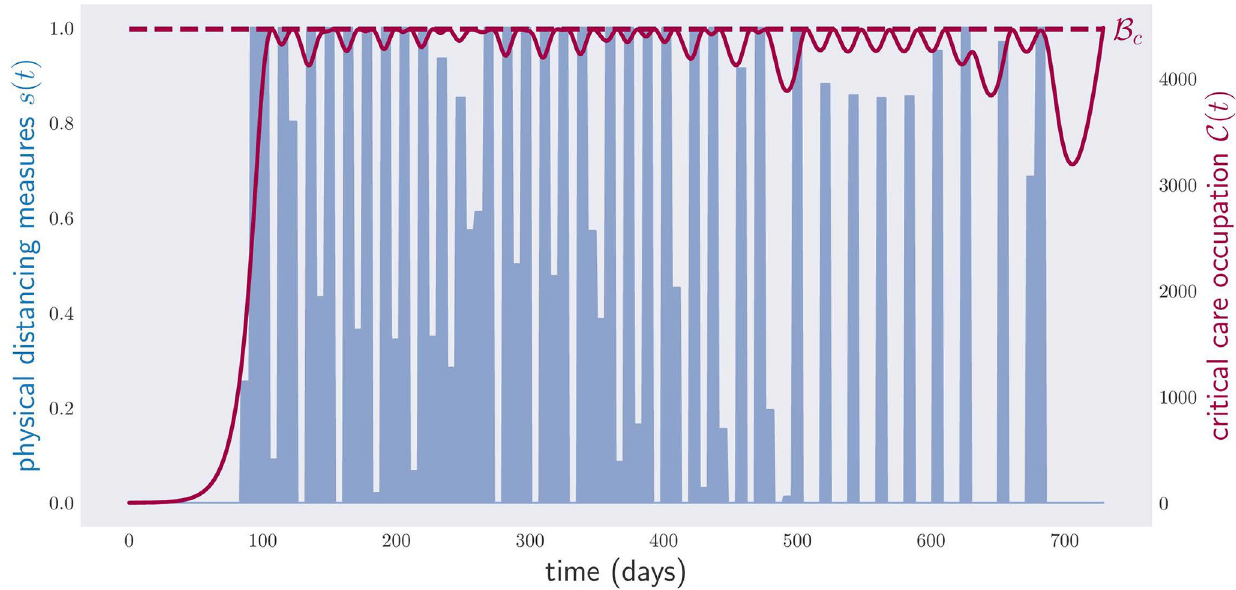
Fig 4. Occupation of critical care beds (red) and physical-distancing measures (blue) for a period of two years. The optimization has been performed over continuous weekly policies, 104 continuous parameters, i.e., any value of physical-distancing measure s between 0 and 1 is accepted. The algorithm, however, tends to prefer 0/1 configurations, i.e., full lockdown or no lockdown in most instances. https://doi.org/10.1371/journal.pone.0257958.g004 week, the computer would have found a tighter solution, with every peak of the red curve touching the dashed line. Even under this discrete weekly simplification, the solution found by the computer is non-trivial: it requires the government to declare a lockdown 27 times (as we will soon see, one can limit the total number of lockdowns in the final policy by adding